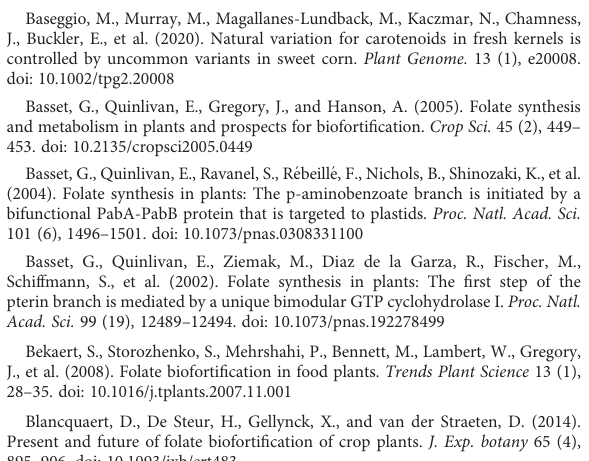
SUPPLEMENTARY FIGURE 4 Protein analysis and phylogenetic analysis of ZmFCL . (A) Protein model of ZmFCL . Blue and pink regions represent N-terminal and C-terminal subdomain superfamily, respectively. The substitution of amino acid translated by causative variation was highlighted with yellow circle. (B) The neighbor-joining phylogenetic tree of ZmFCL and its orthologs from major cereals and vegetables. Bootstrap values from 1,000 replicates are indicated at each node, and the scale represents branch length. ZmFCL (B73)andZmFCL(RC)represented fi eldcornandsweetcorn,respectively.